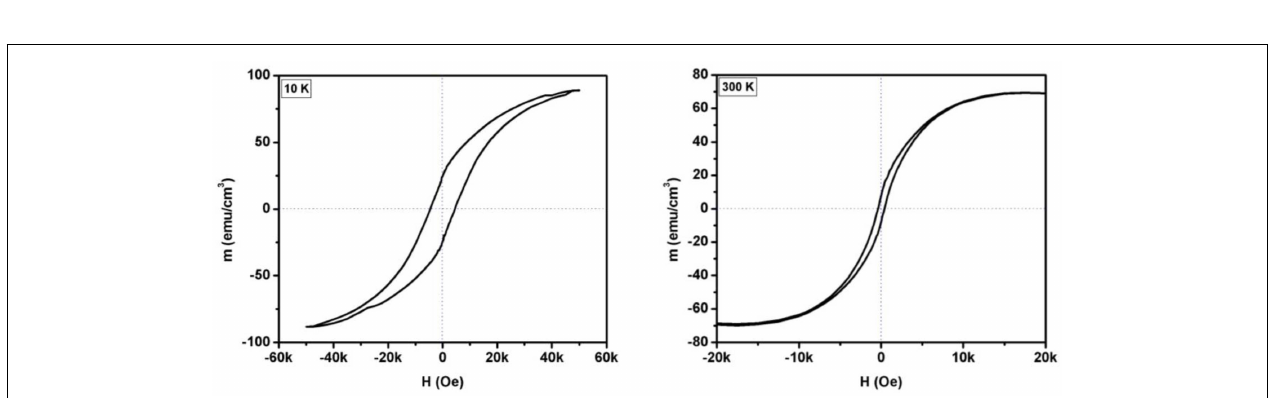
FIGURE 5 | M vs .T plots for SnFe 2 O 4 film at different magnetic fields under FC and ZFC conditions .